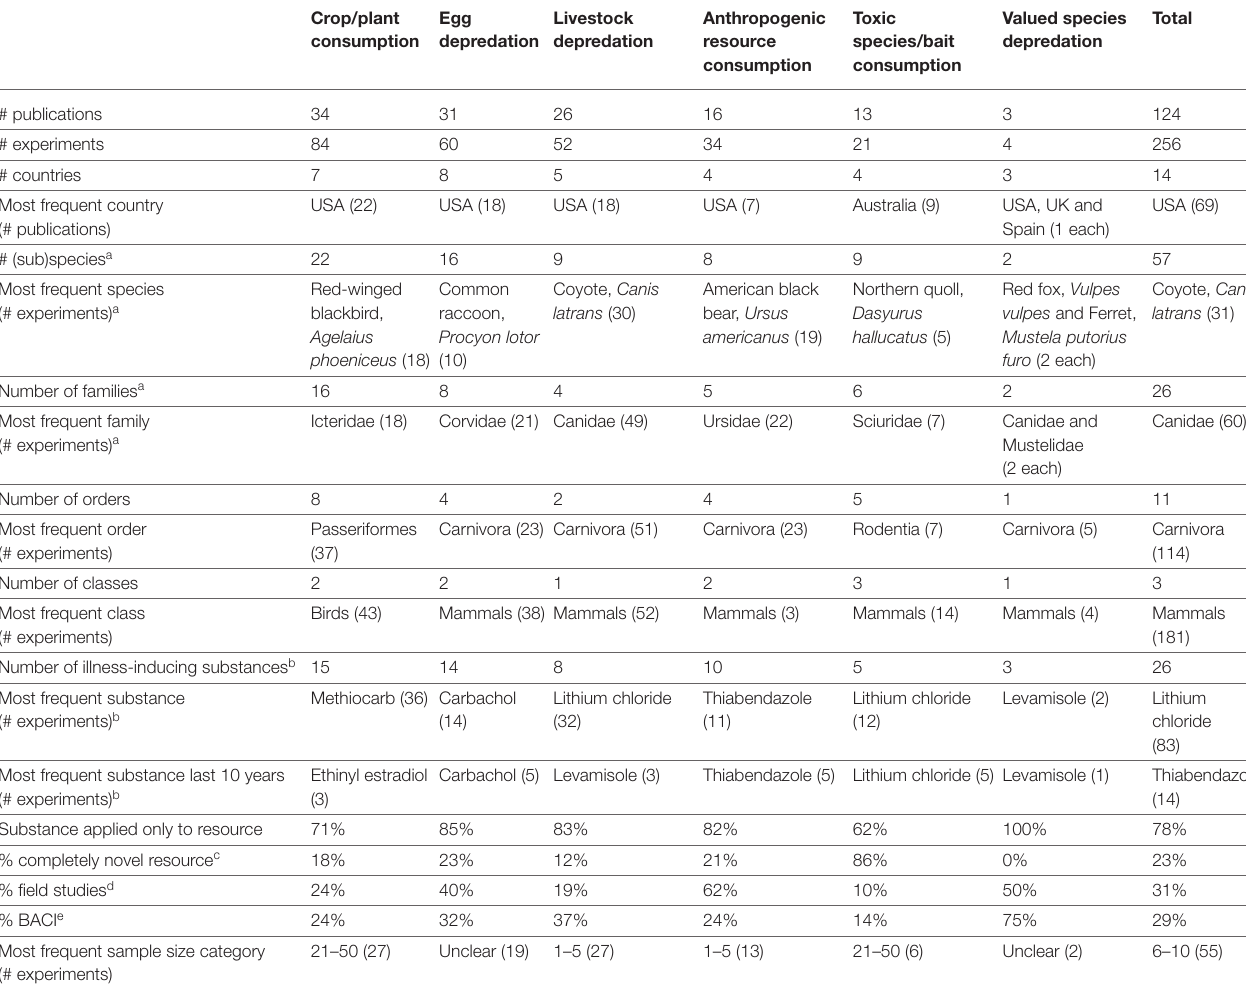
TABLE 1 | Overview of the evidence base on the use of CTA in six HWC